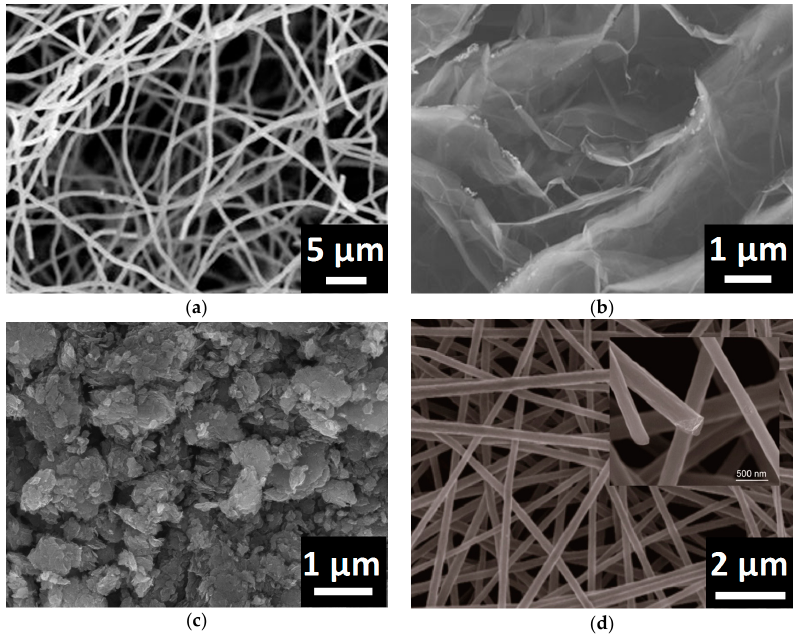
Figure 6. SEM images of various carbon-based materials (( a ) carbon nanofiber (CNF); ( b ) grapheme; and ( d ) carbon nanotubes (CNT) and ( c ) GONF which used in this study. (conversion: 1 μ m = 0.0394 mil) (reproduced with permission from [28]. Copyright IOP Publishing,